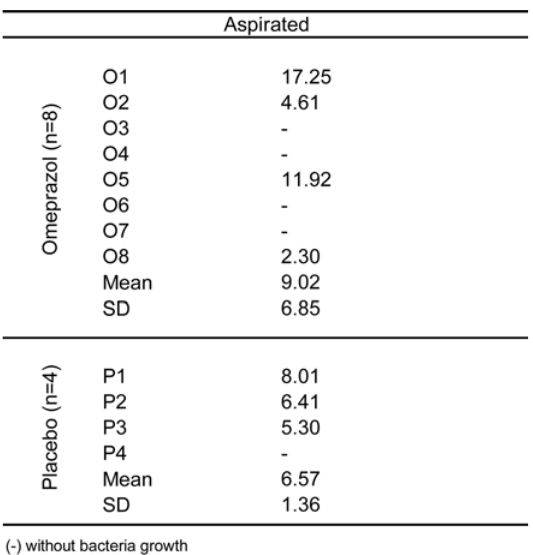
TABLE 1 - Quantity of bacteria [Ln(UFC/mL)] obtained in each sample by aspiration tecnique after administration of omeprazol/placebo.